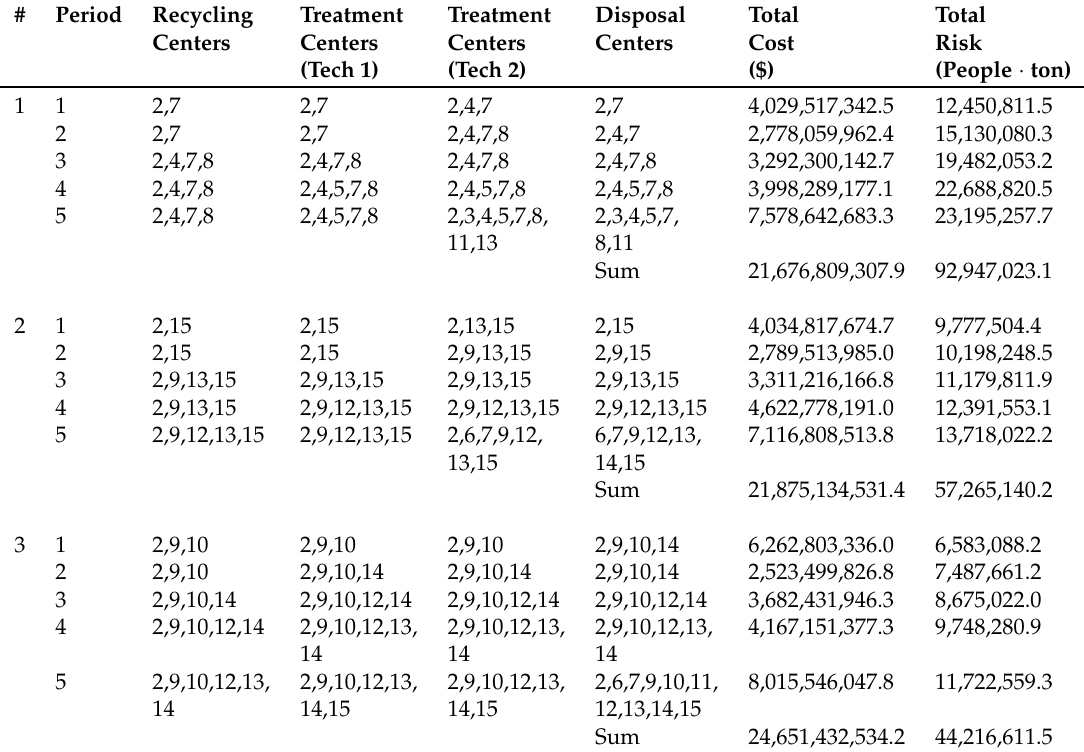
Table 6. Representative solutions (single period